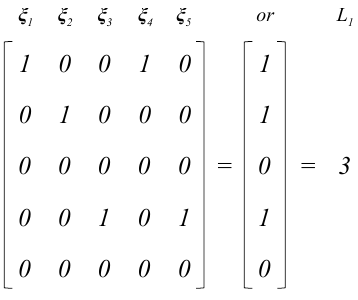
Figure 2. Illustration of the regularity energy as in Equation 4, which is the total number of selected models.